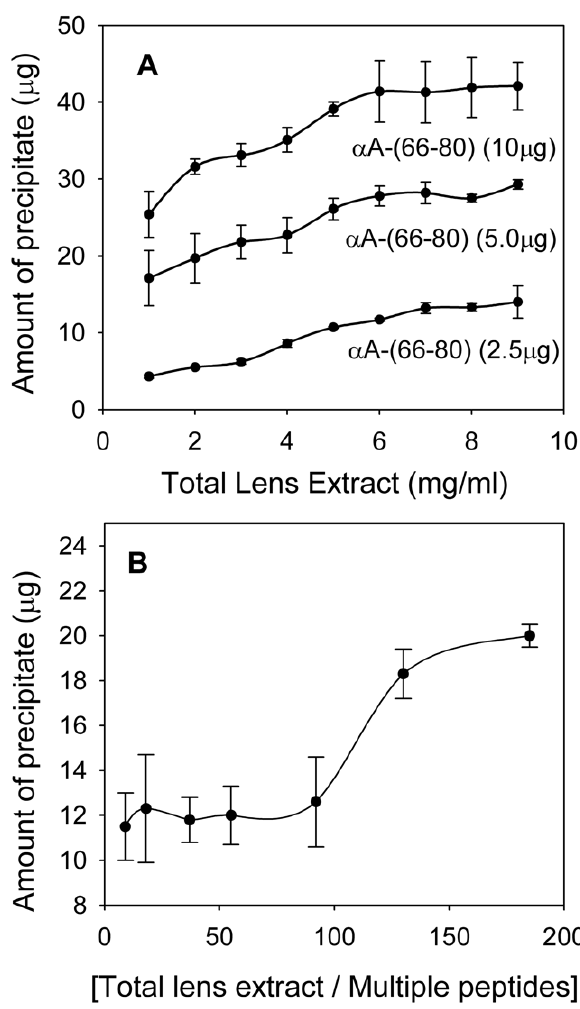
Figure 5. Effect of protein concentration on peptide-induced aggregation of human lens proteins. (A) Lens crystallin fraction (0.5–9 mg) was incubated with 2.5–10 m g of a A-(66-80) peptide in 1 ml buffer at 37 u C. The amount of protein precipitated after 24 h was estimated using Bio-Rad protein assay reagent (n=3). The amount of precipitate formed increased when the reaction mixture contained increased amounts of peptide or lens extract. (B) Effect of a mixture of peptides on lens proteins. Different concentrations of dialyzed human lens extract were mixed with a mixture of peptides consisting of a A-(66- 80), a A-(66-75), a A-(67-75), a B-(1-18) and b A3/A1-(102-117), 1.0 m g each, to obtain 5- to 200-fold excess (by weight) of crystallins. The mixtures were incubated at 37 u C for 24 h in 1 ml of 50 mM phosphate buffer, pH 7.2. The precipitate formed was collected by centrifugation and estimated as above. The results show that the presence of several peptides in low concentration is sufficient to induce lens crystallin precipitation when the crystallin concentration is high. Therefore, an in vivo lens protein concentration of 400 mg/ml is likely to aggregate and precipitate even when the peptide concentration is 100’s of times lower than that of crystallins.